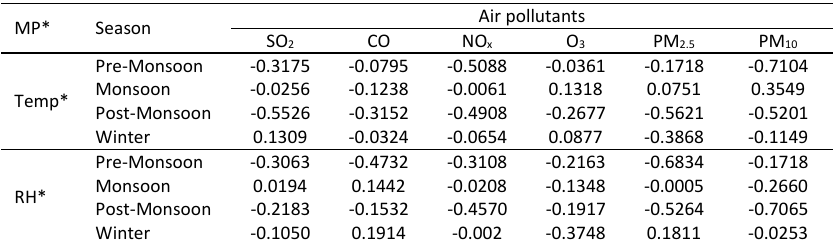
Fig. 4. Bargraphs showing seasonal variations of mean air pollutants concentration across the years. Different letters above the error bars denote significant differences at α≤0.05. Homogeneous subsets are not significantly different based on Tukey’s HSD post-hoc test. Table 4: Summary of season wise Spearman correlation coefficient (r) values between air pollutants and meteorological parameters (Values in bold are different from 0 with a significance level alpha=0.05)